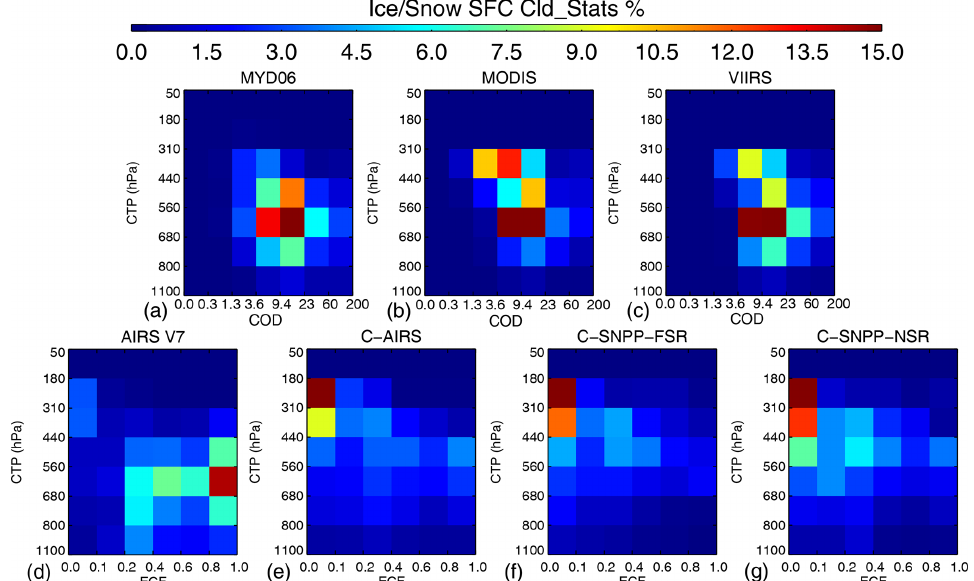
Figure 13. Similar to Figs. 10–12, except showing results calculated using data over snow- and ice-covered surfaces (Ice/Snow SFC). Sounder retrieved surface classes are used to identify